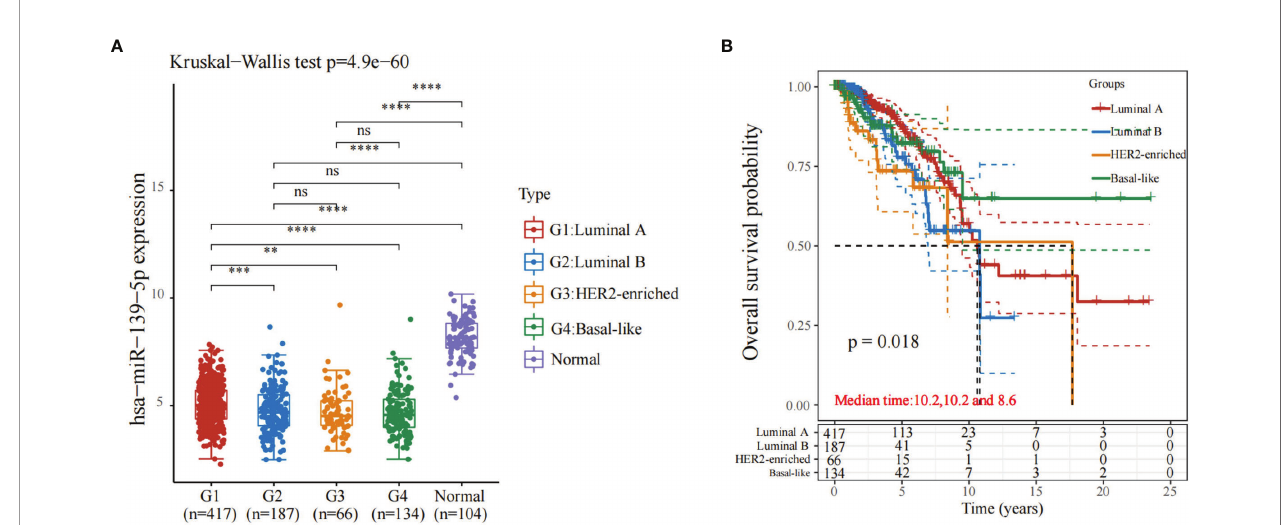
FIGURE 1 | Expression and prognosis of miR-139-5p in different types of breast cancer. (A) Expression of miR-139-5p; (B) Prognosis of different types of breast cancer. **P < 0.01, ***P < 0.001, ****P < 0.0001. ns, no signi fi cance.